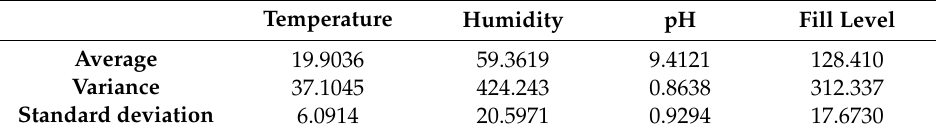
Table 7. Characterization of variables: Scenario 2 (02:00–14:00) 3 .